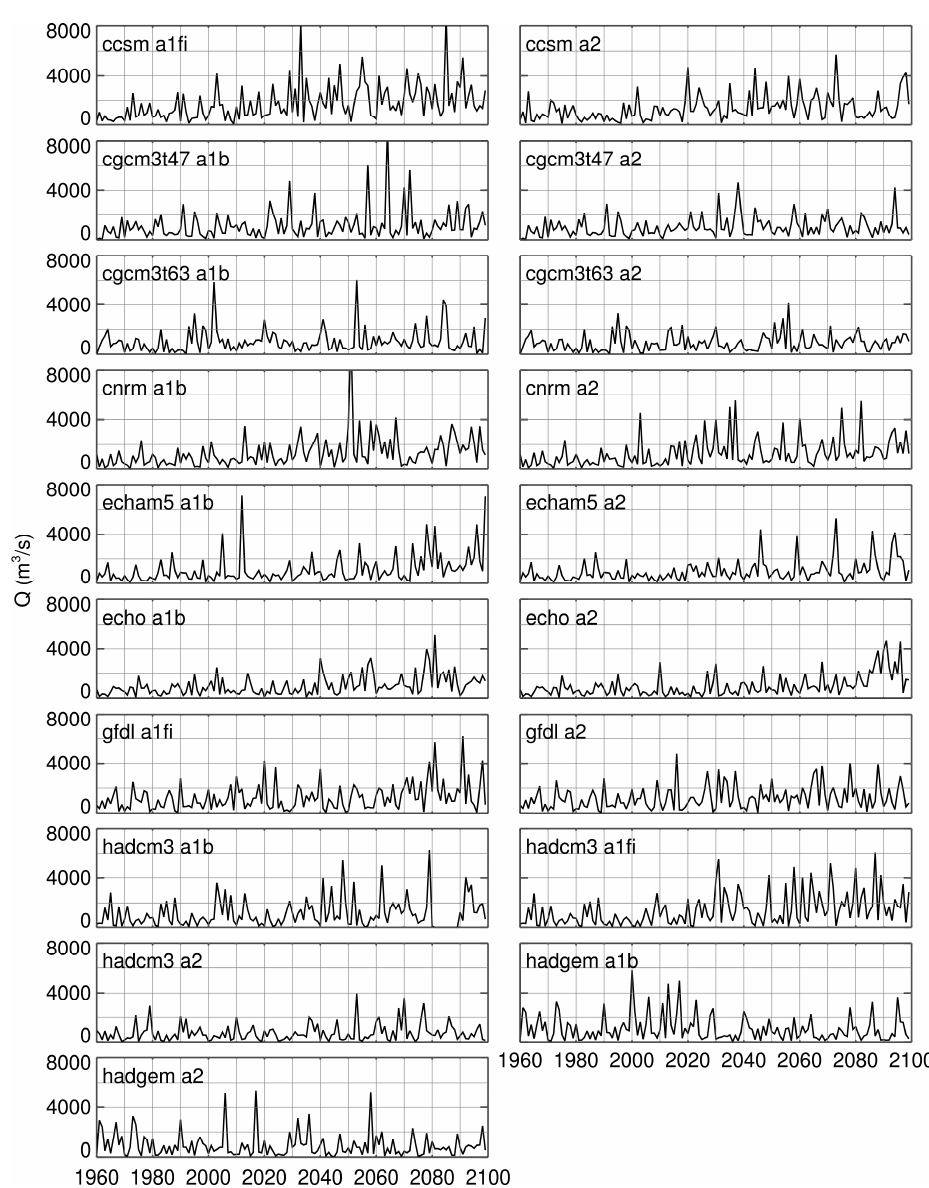
Figure 4. Projected annual peak flows in the bridge of US 151 in Cedar River at Cedar Rapids.